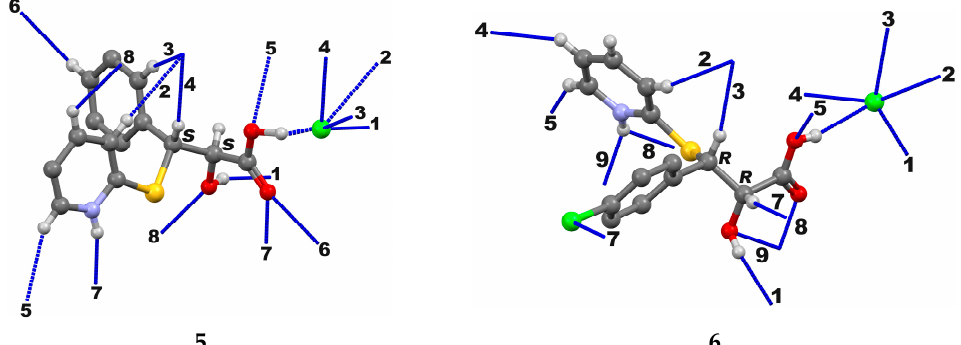
Figure 4. Hydrogen bonds in 5 and 6 (shown as dashed blue lines).